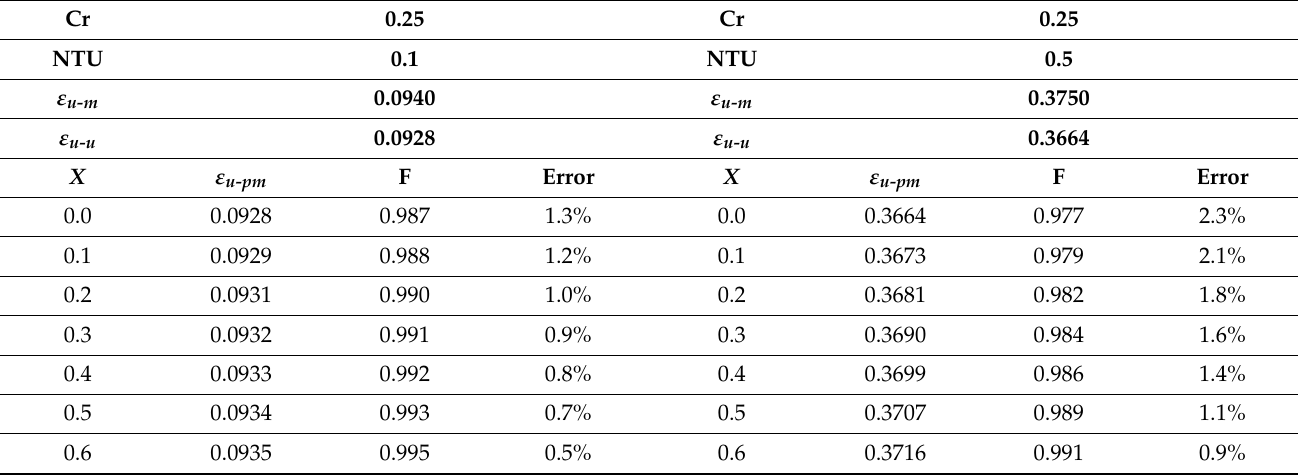
Table A1. Effectiveness correction factor “F” and Error in effectiveness estimation—3-row pure cross flow heat exchanger. Unmixed—external fluid & mixed/partially mixed—tube side fluid; Cr =